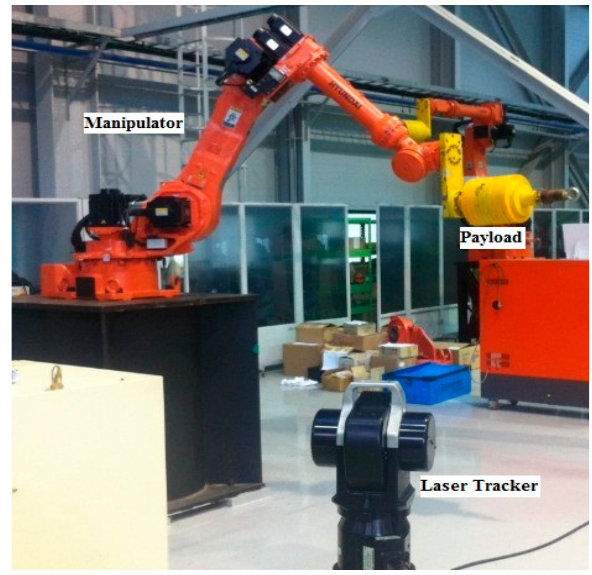
Figure 4. Experimental setup.